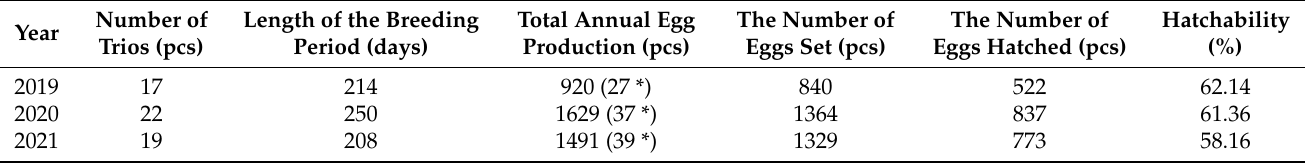
Table 1. Egg production and hatchability in the examined years.